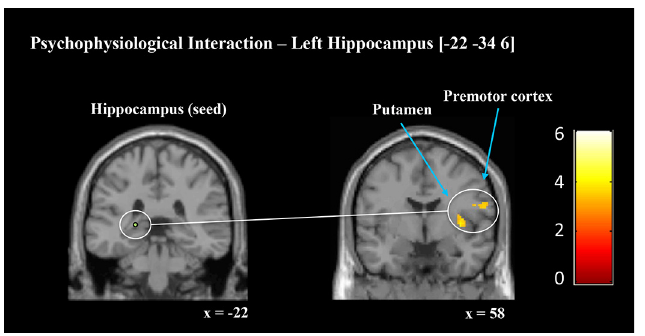
Fig 4. Regions of increased functional connectivity after TMR. A PPI analysis revealed enhanced connectivity for the cued sequence between left hippocampus ( − 22, − 34, 6) and right putamen (36, − 2, 4) and PMC (58, 4, 22). Contrasts displayed as sagittal and coronal projections superimposed on a standard MNI brain. Colour bar indicates t-values. Anatomical labelling based on peak z-score location.